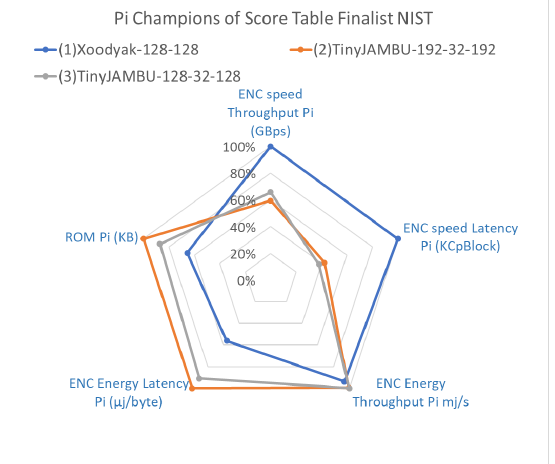
Figure 30. Radar graph of the three NIST finalists winners in 5 measures in